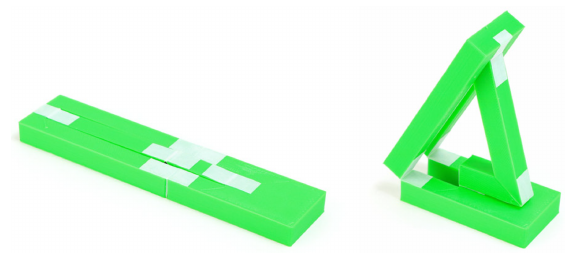
Figure 7. A simplified planar deploying strut ThUDS based on the general PTHS model (Andrews et al., 2019). Shown in flat and de- ployed states.